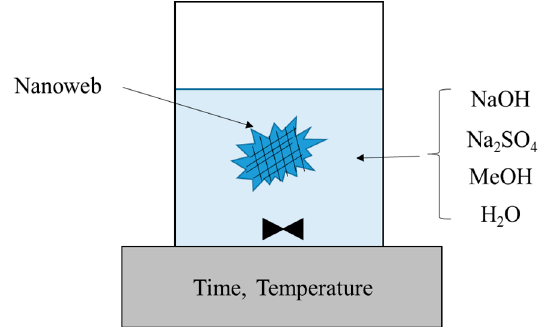
Figure 1. Schematic illustration of the heterogeneous saponification process employed for manufacturing of PVA nanofiber mats.